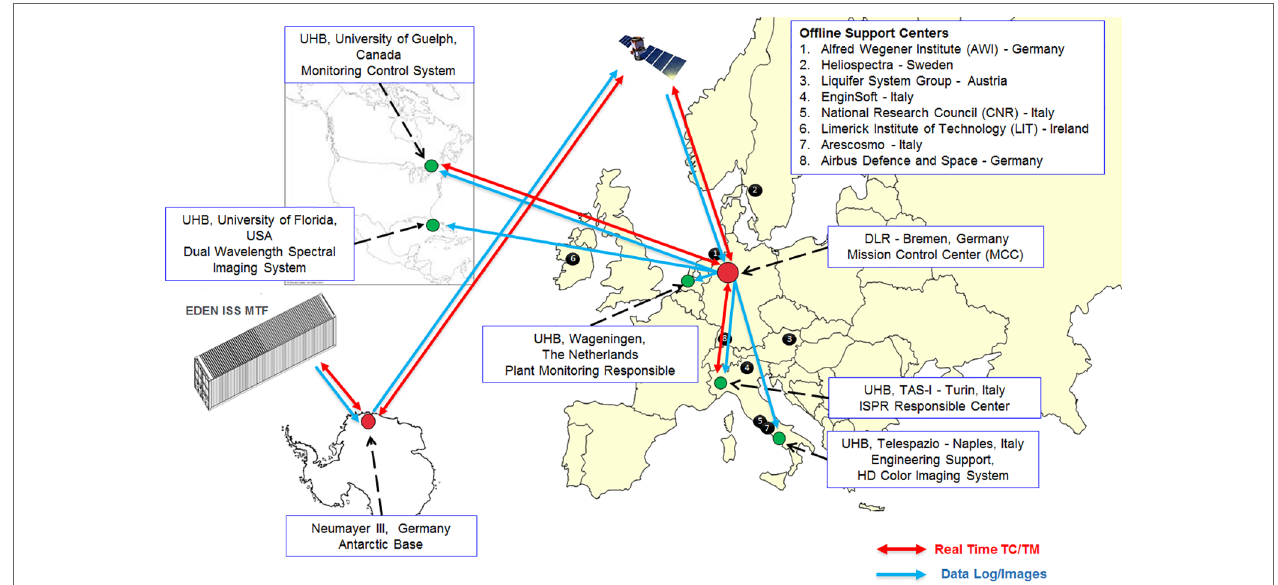
FIGUrE 1 | Top-level data streams in the EDEN ISS remote operations network including the MCC, the UHBs, and the offline support centers.